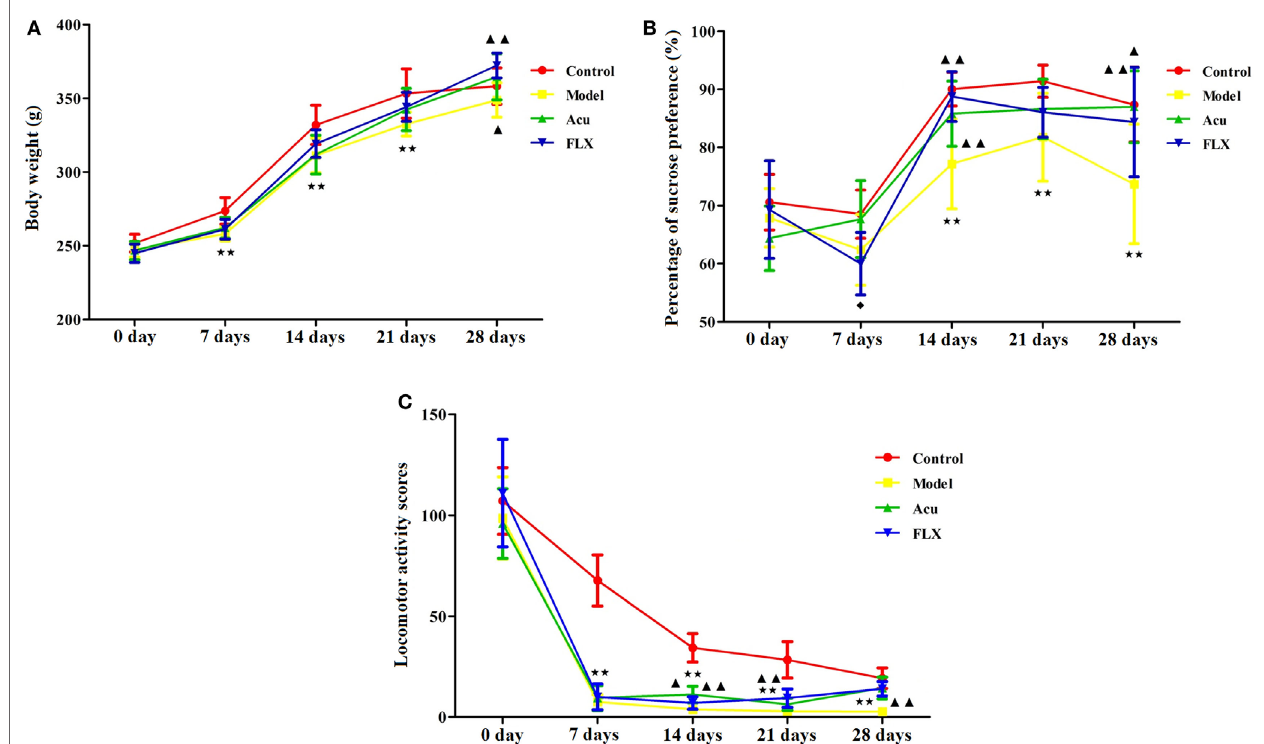
FigUre 3 | Differences showing the effects of stress/antidepressant treatments on depressive-like behaviors in depression rats induced by chronic unpredicted mild stress. Acu, acupuncture group; FLX, fluoxetine group. Differences were assessed with two-way analysis of variance (ANOVA) with Tukey’s post hoc test. Results were presented as mean ± SD. (a) Results of two-way ANOVA with time points and groups of changes in BW were as follows: time points, F = 4.142, P = 0.000; group, F = 8.794, P = 0.000; interaction, F = 1,220.311, P = 0.000. ★★ P < 0.01 compared with the control group; ▲ P < 0.05 compared with the model group; ▲▲ P < 0.01 compared with the model group. (B) Results of two-way ANOVA with time points and groups on changes in sucrose consumption were as follows: time points, F = 107.438, P = 0.000; group, F = 20.266, P = 0.000; interaction, F = 2.788, P = 0.000. ★★ P < 0.01 compared with the control group; ▲ P < 0.05 compared with the model group; ▲▲ P < 0.01 compared with the model group; ⬩ P < 0.05 compared with the acupuncture group. (c) Results of two-way ANOVA with time points and groups on changes in locomotor activity scores were as follows: time points, F = 569.024, P = 0.000; group, F = 68.783, P = 0.000; interaction, F = 11.279, P = 0.000. ★★ P < 0.01 compared with the control group; ▲ P < 0.05, compared with the model group; ▲▲ P < 0.01 compared with the model group; ⬩ P < 0.01 compared with the acupuncture